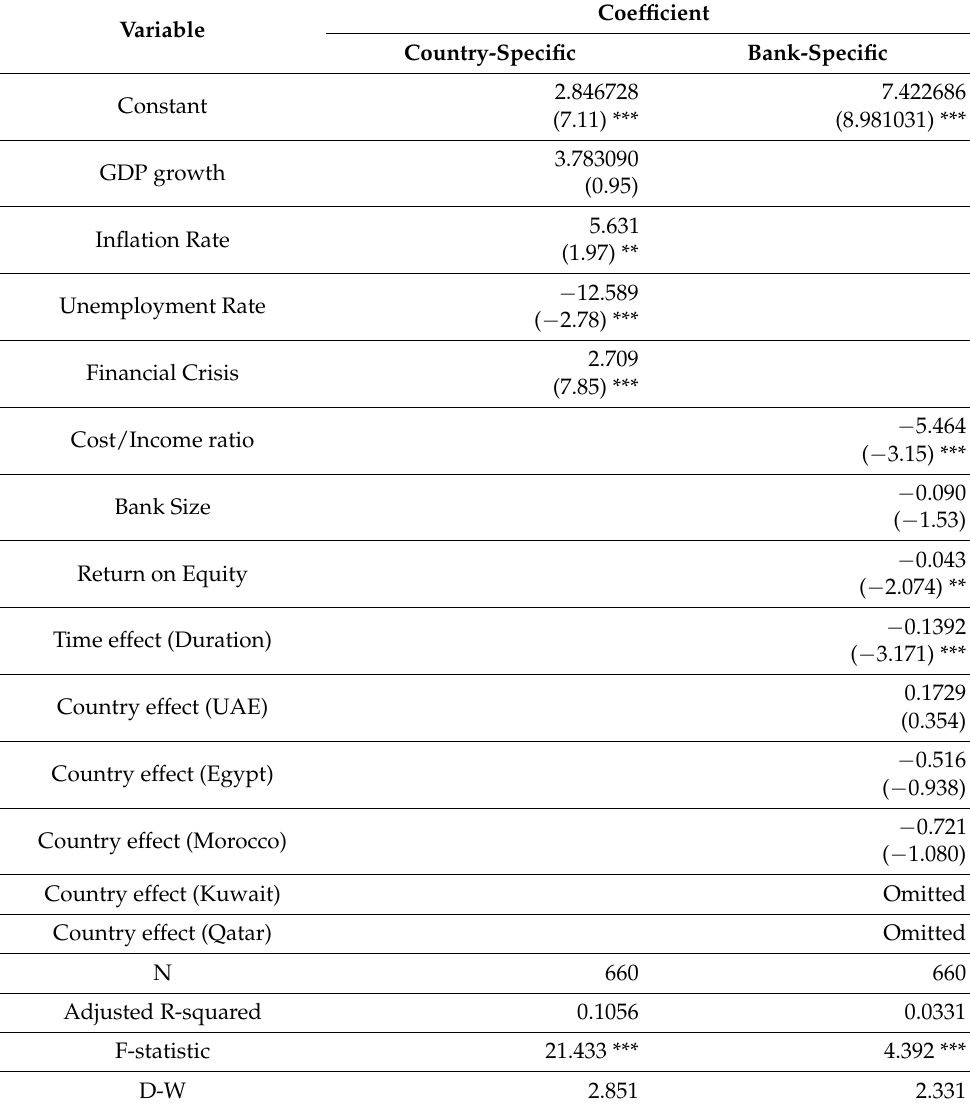
Table 3. The Effect of Country-Specific Variables on Banks’ Z-score. The dependent variable was Z-score, being a proxy for the overall bank risks. The independent variables were classified into two groups: country-specific and bank-specific variables. The multicollinearity was examined using the VIF test. All variables were associated with VIF < 10 (Gujarati 2003). The results are reported in Table A1. The presence of heteroscedasticity was examined in the regression model by conducting the Breusch-Pagan test. The results in Table A4 show that the error variance was constant and had no heteroscedasticity problem. The presence of autocorrelation was examined as well using the Durbin-Watson test. Therefore, the first difference transformation was applied to sort out the autocorrelation